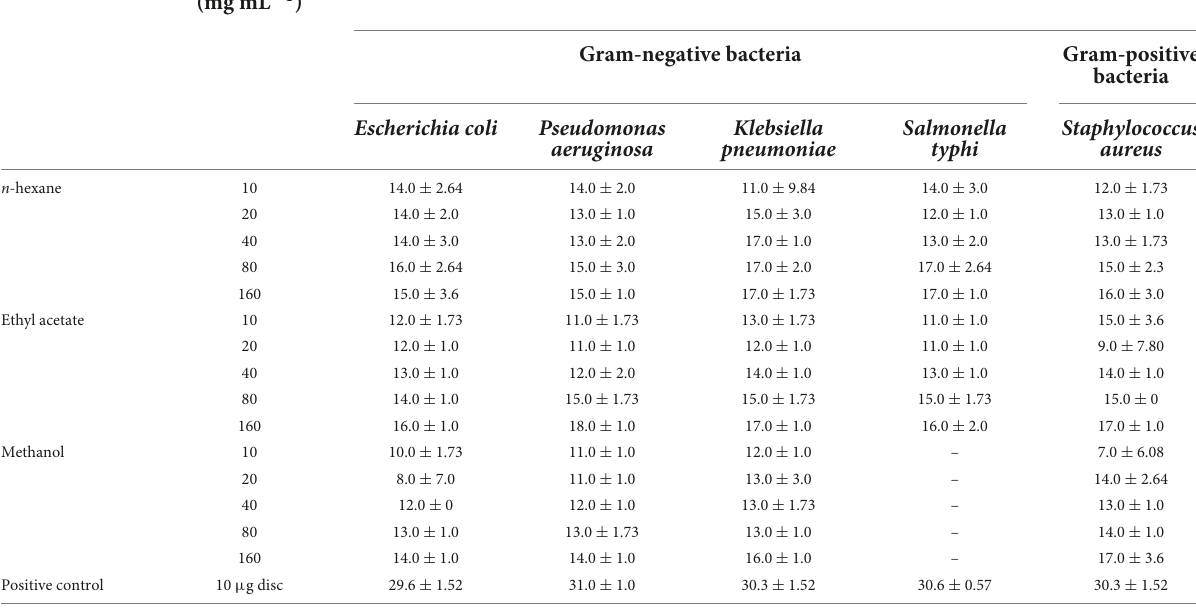
TABLE 5 In-vitro antibacterial activity of Skimmia anquetilia root extracts against tested bacterial strains. Organic extract